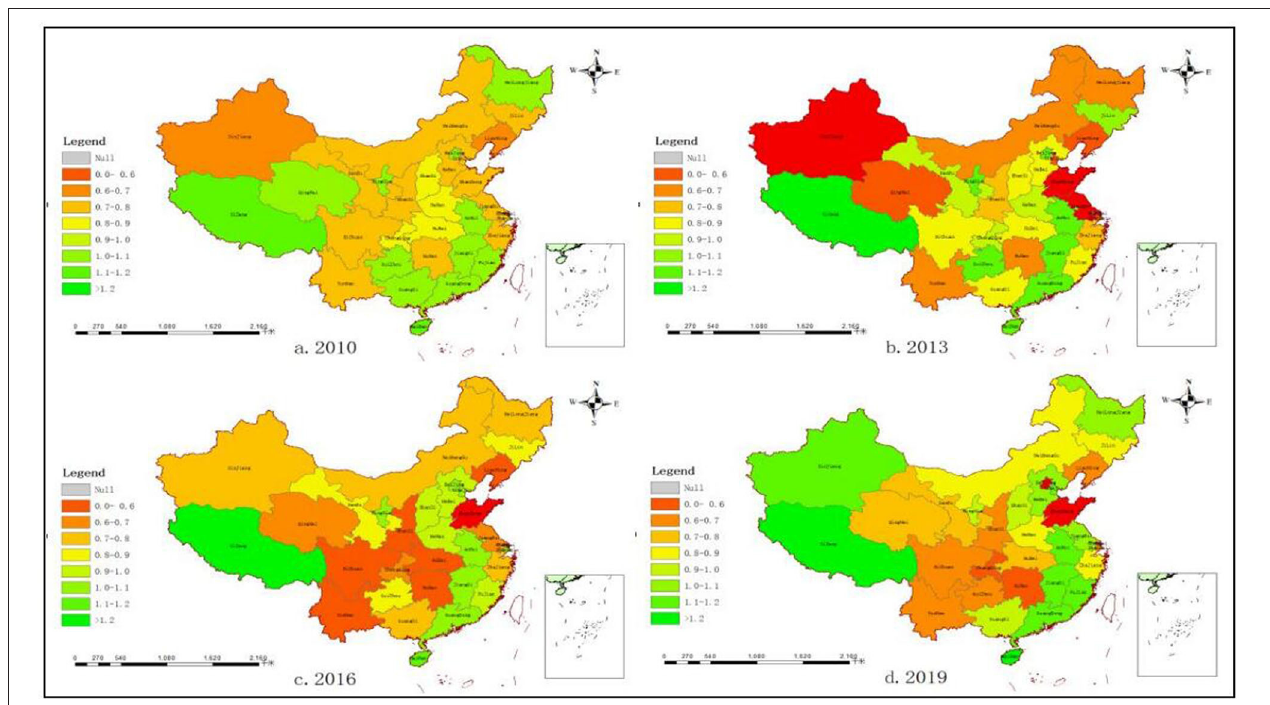
FIGURE 3 | Distribution of health production efficiencies in 31 provinces and cities in China. (A) Distribution of health production efficiencies in 2010. (B) Distribution of health production efficiencies in 2013. (C) Distribution of health production efficiencies in 2016. (D) Distribution of health production efficiencies in 2019.